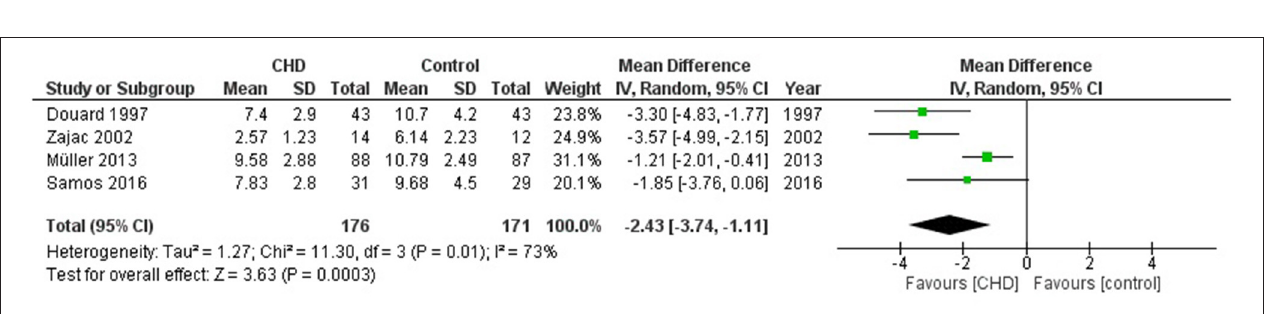
FIGURE 7 | Forest plot for mean oxygen pulse for CHD in children and adolescents and healthy